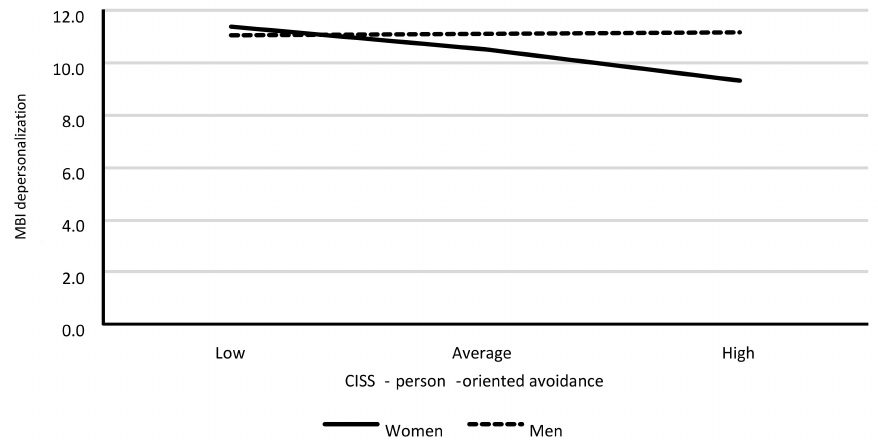
Figure 4. Associations between POA and depersonalization, separately for each